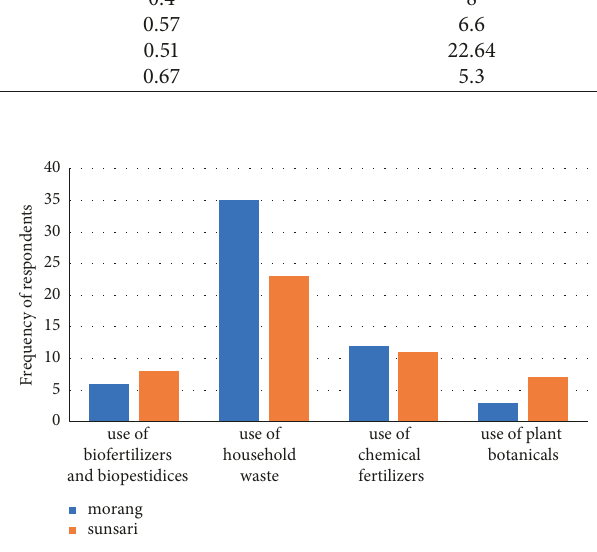
Figure 8: Tools of plant growth and management in rooftop gardens in study